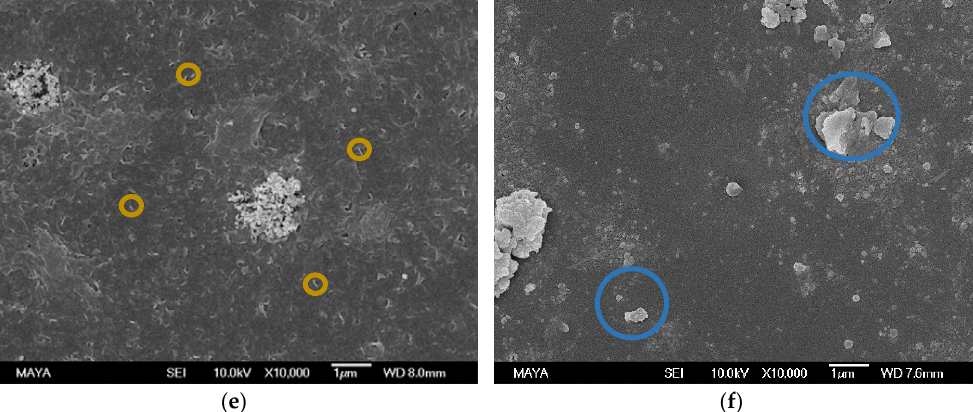
Figure 2. SEM images of membrane samples after: ( a ) conditioning, ( b ) fouling with ThMP process water, ( c ) NaOH + NaOH cleaning, ( d ) U10 + U10 cleaning, ( e ) EC + NaOH cleaning, and ( f ) EC + U10 cleaning. Objects assignment: assumingly extractives (circle in blue), assumingly enzymes (circle in brown), unassigned (red square).